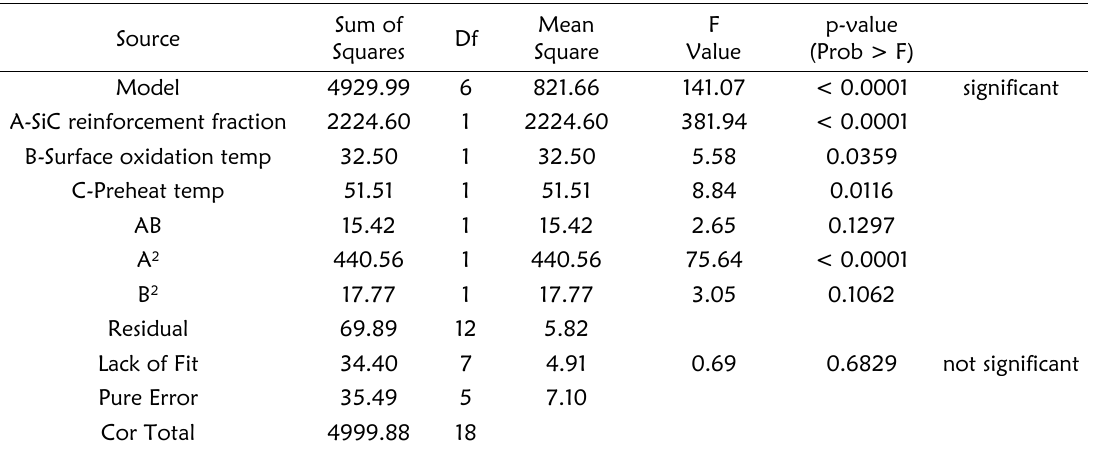
Table 6: Analysis of variance for wear